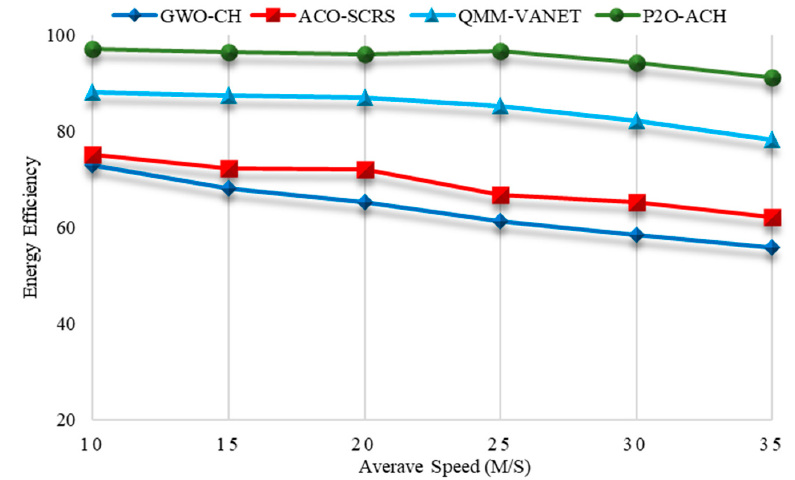
Figure 10. Energy Efficiency Calculation.